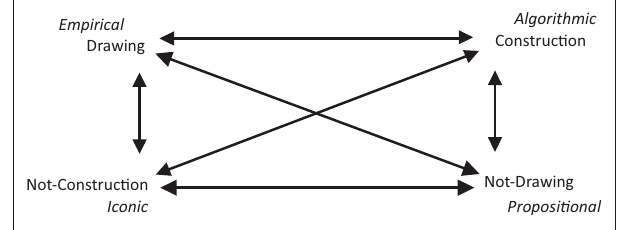
FIGURE 7: Revised regulative orientations mapped onto the construction- drawing opposition.